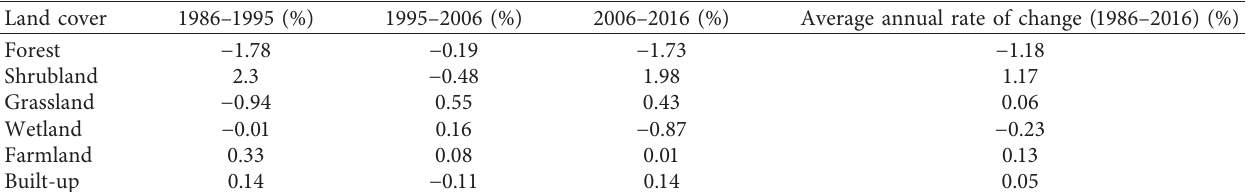
Figure 3: Land cover maps for the period 1986–2016 for West Bugwe Central Forest Reserve. Table 5: Average annual rates of change in percentage between the years 1986, 1995, 2006, and 2016 for the classified land cover classes in West Bugwe Central Forest